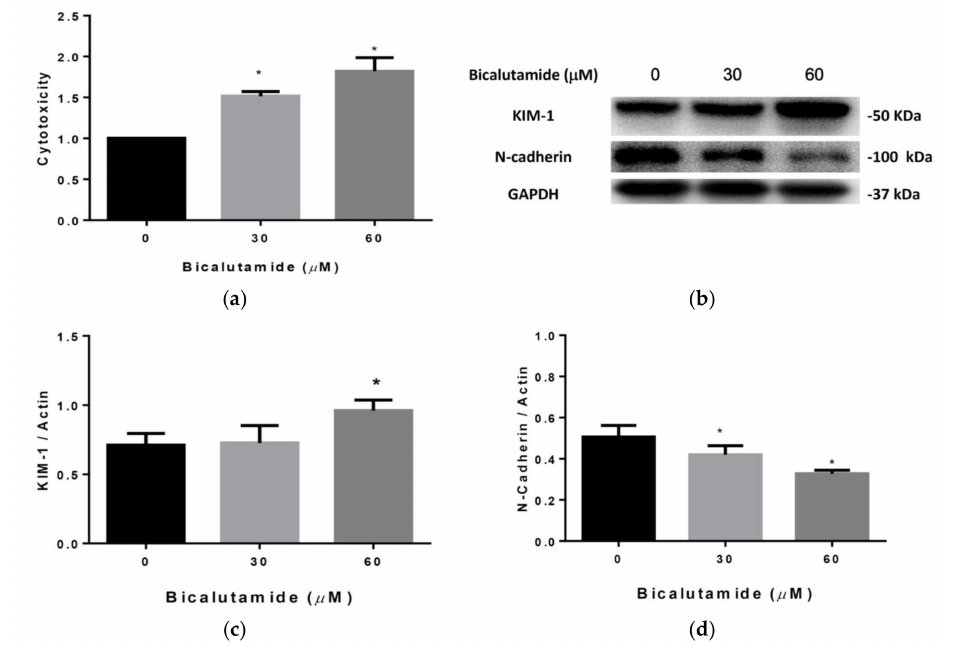
Figure 1. Lactate dehydrogenase (LDH) assay and the Western blot of kidney injury molecule (KIM)-1 and N-cadherin in rat mesangial cells (RMCs). Cells were treated with bicalutamide (Bic) at concentrations of 30 and 60 µ M at 24 h. ( a ) LDH release was increased by Bic ( n = 3, * p < 0.05). ( b ) A representative blot of protein expressions of KIM-1 and N-cadherin. GAPDH was used as an internal control. ( c ) Quantitative data of Western blotting of KIM-1( n = 3, * p < 0.05). ( d ) Quantitative data of Western blotting of N-cadherin ( n = 3, * p < 0.05). When RMCs were treated with Bic, N-cadherin dose-dependently decreased, however KIM-1 was significantly induced in the group treated with 60 µ